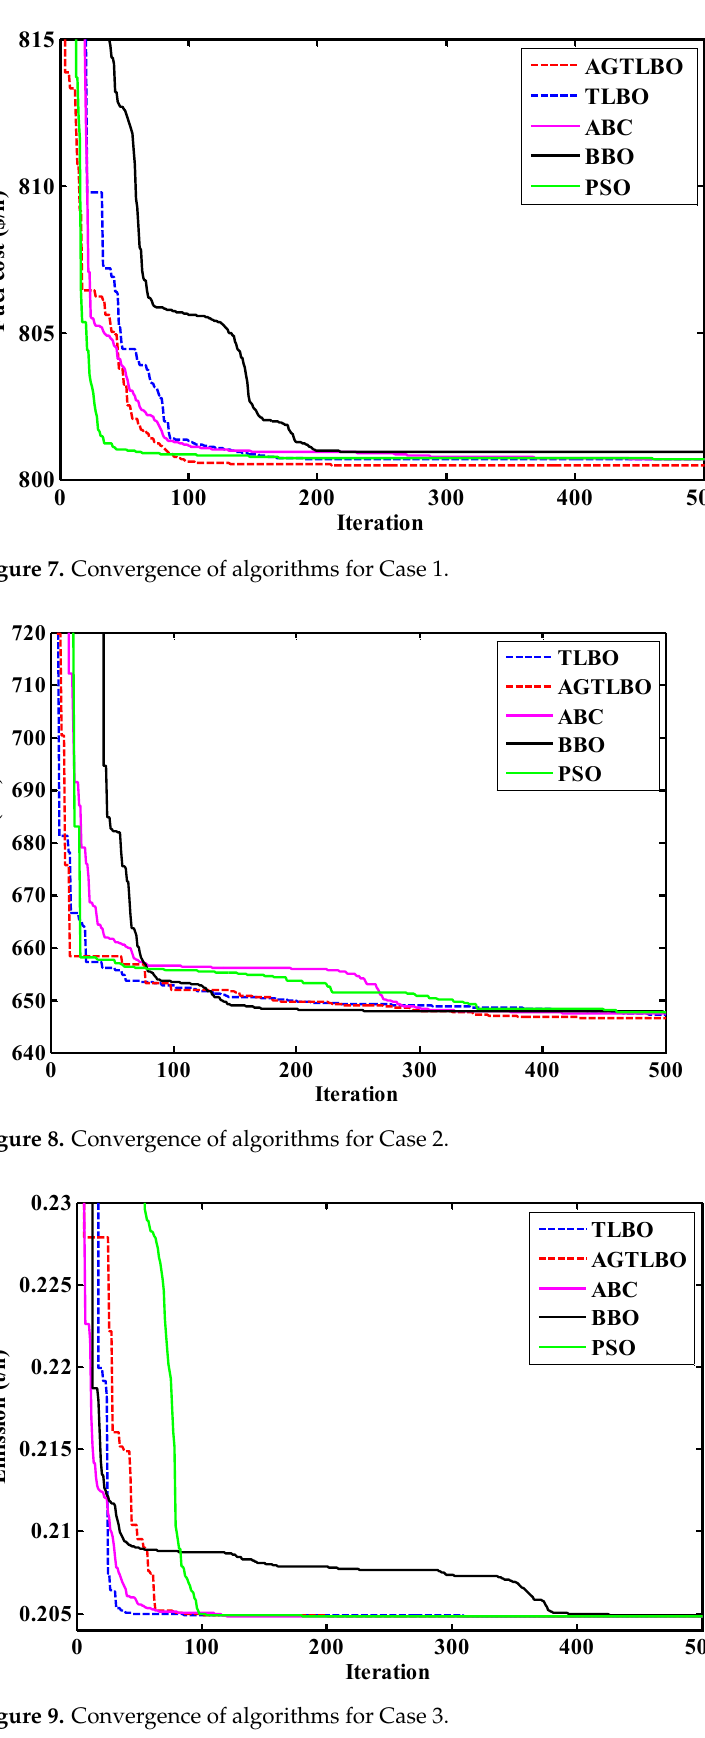
Figure 9. Convergence of algorithms for Case 3.